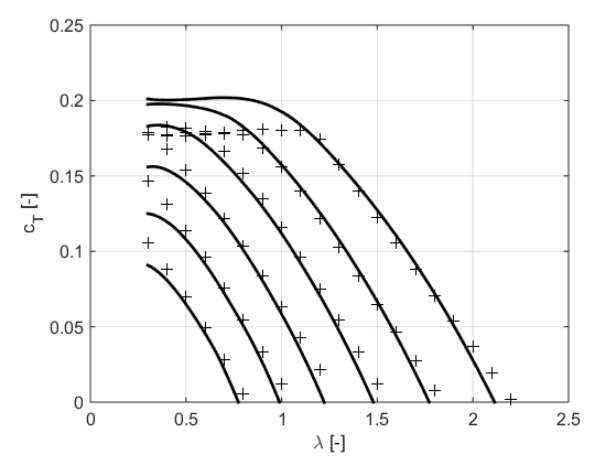
Figure A3. Comparison of computed values of thrust coefficient c T (solid lines) with experimental results from [8] (discrete points) for the three-blade propeller 5868-R6.